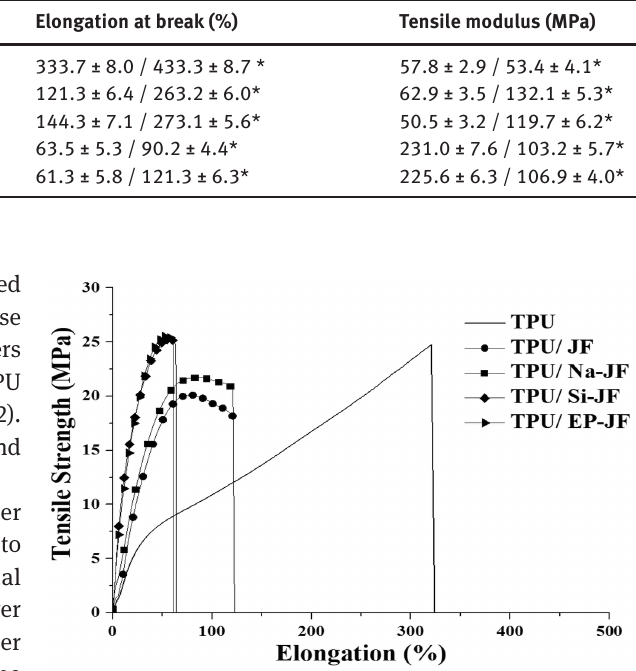
Table 2 : Tensile test data of composites before and after absorption test.